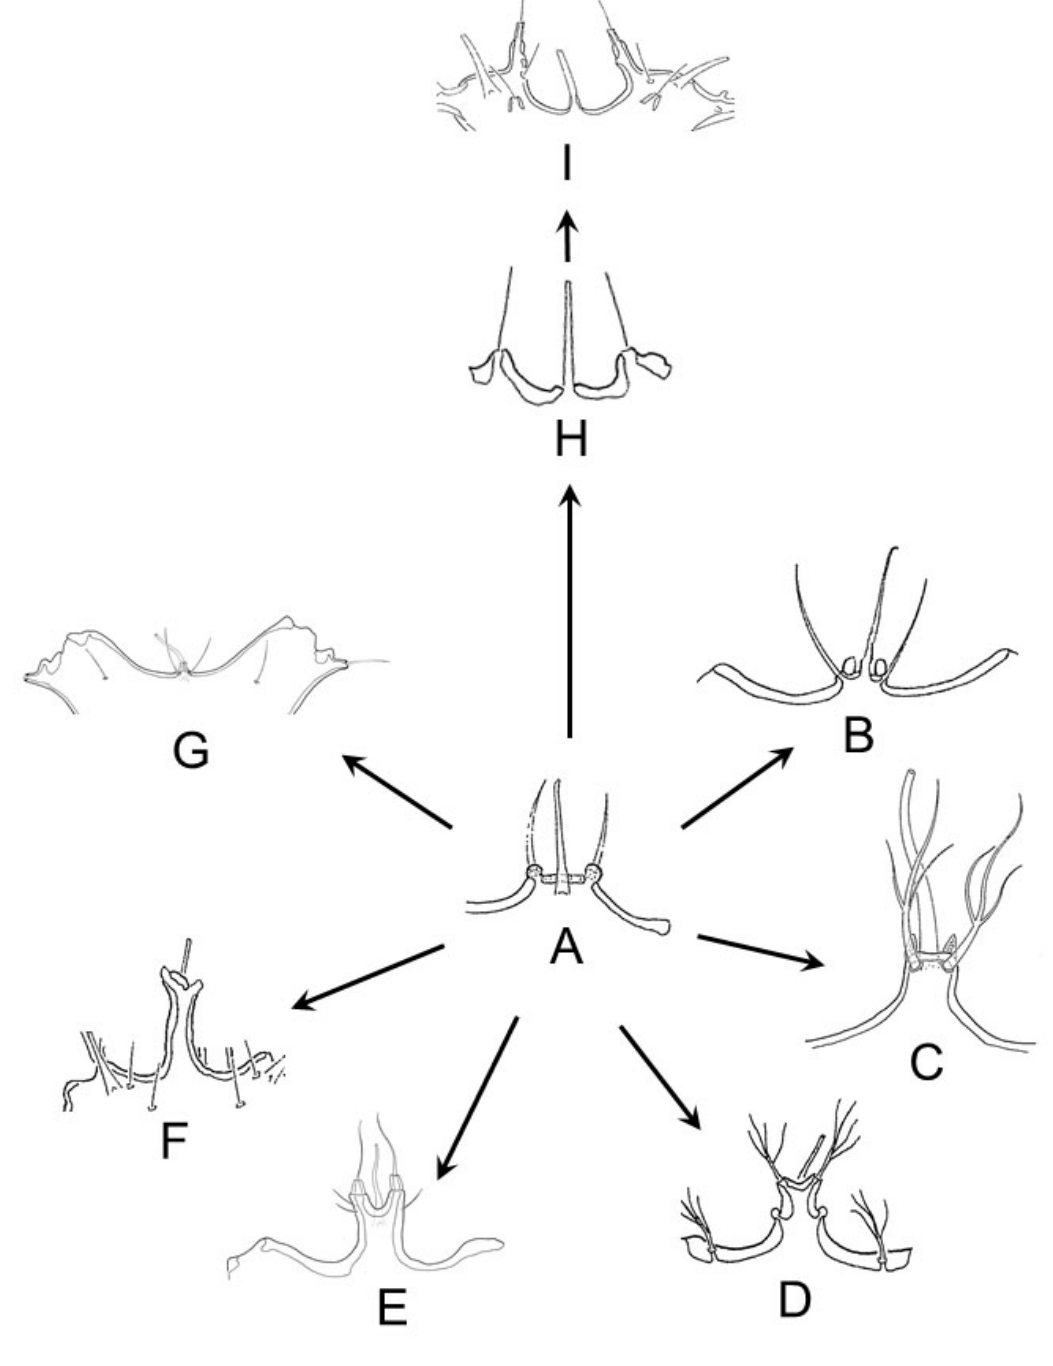
Fig. 20. Rostra. A . Touphapleura schminkei (George, 1998). B . Polyascophorus martinezi George, 1998. C . Dorsiceratus octocornis Drzycimski, 1967. D . Echinopsyllus normani Sars, 1909. E . Pseudopolyascophorus monoceratus gen. et comb. nov. F . Pseudechinopsyllus sindemarkae George, 2006. G . Poropsyllus menzelae gen. et sp. nov. H . Dendropsyllus magellanicus (George & Schminke, 1998). I . Tauroceratus vareschii (George, 2006) gen. et comb. nov. Modified from various authors, no scales. RST in A–B and E